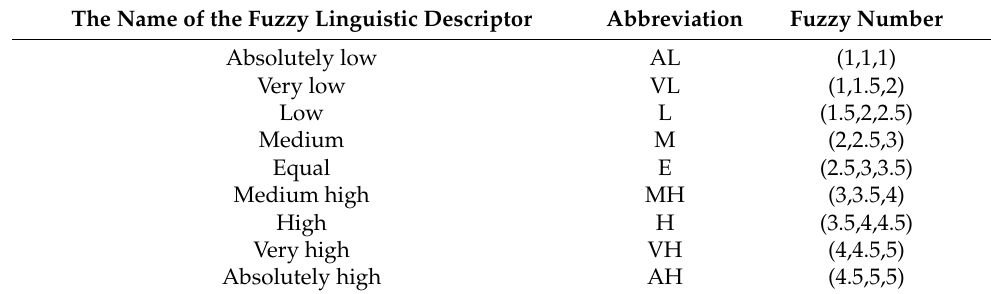
Table 8. Fuzzy scale for criteria